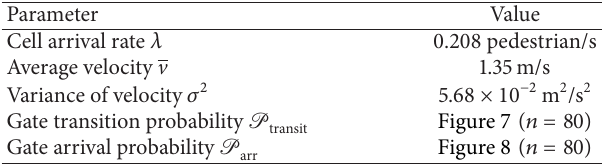
Table 1: Parameters in the observed